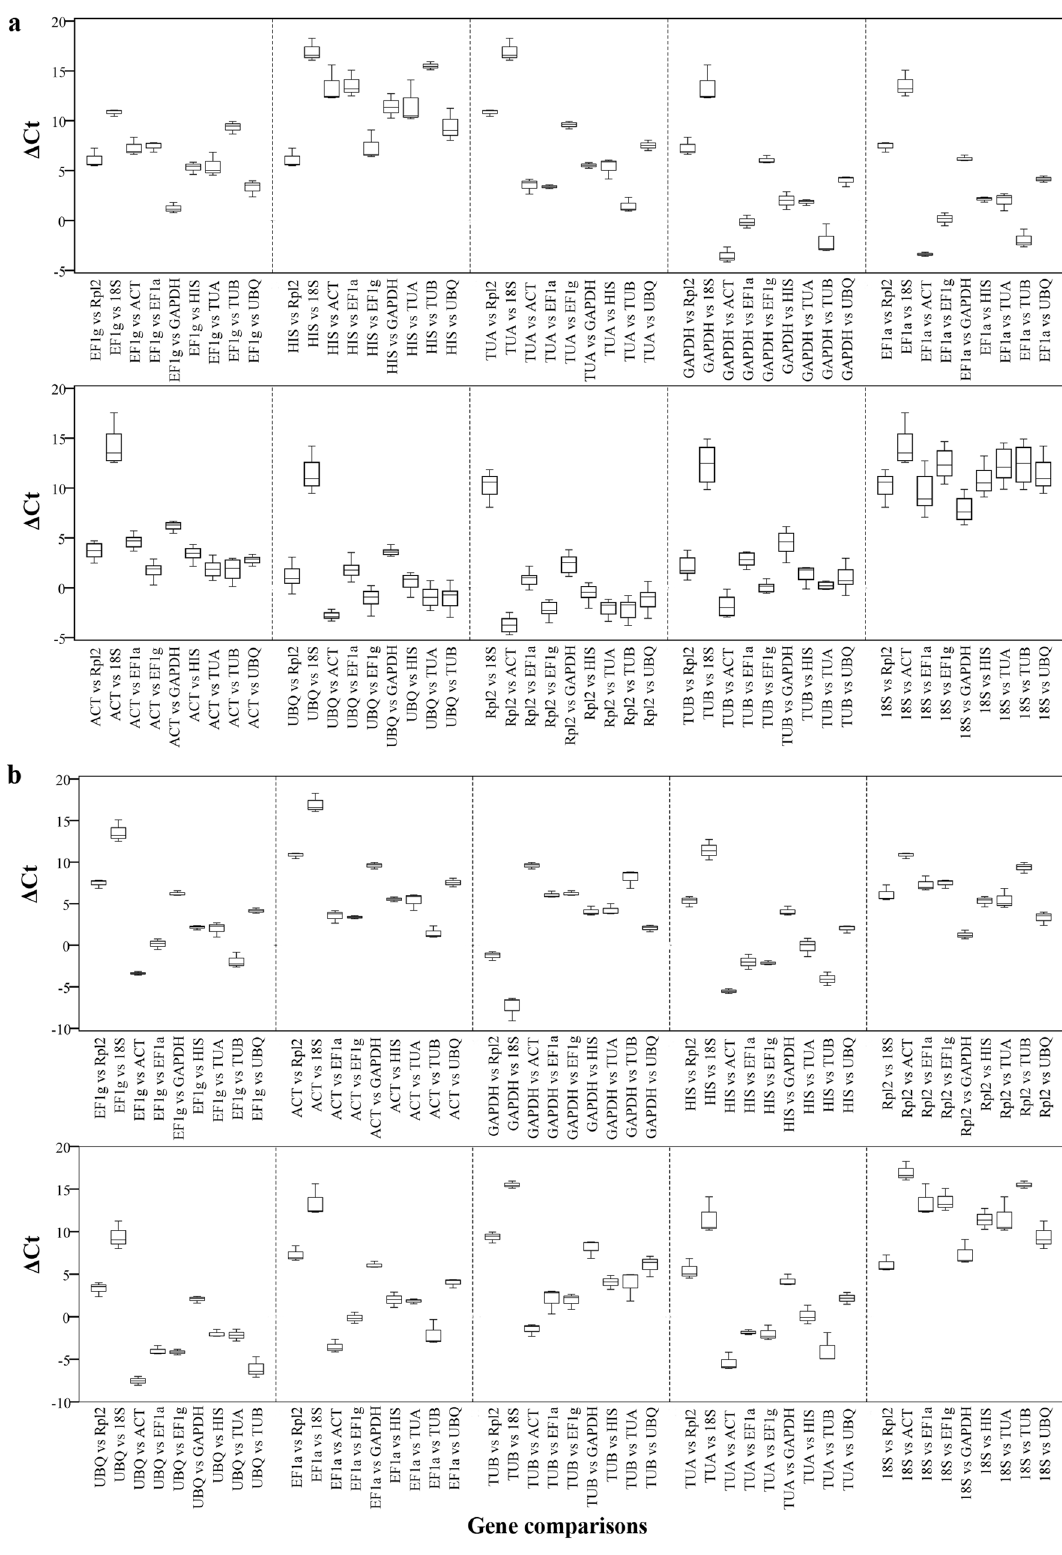
Figure 5. ΔCt method for reference gene selection in Liriodendron hybrids. ΔCt variability in reference gene comparisons are shown as medians (lines), 25th percentile to the 75th percentile (boxes) and ranges (whiskers) for all eight samples in the somatic embryogenesis group ( a ) and three samples in the germination group ( b